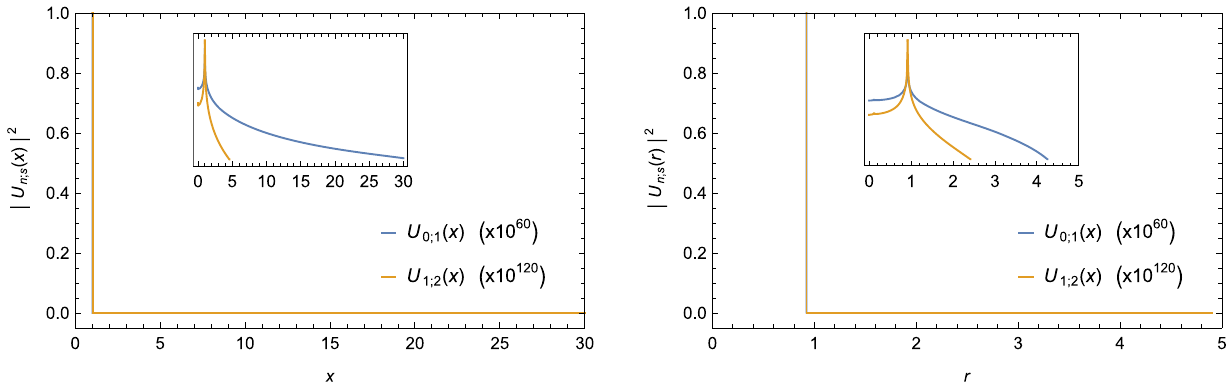
Fig. 6 (dS) Case 2: a > 0. The first two squared QBS radial wave eigenfunctions as a function of the new radial coordinate x (left) and radial coordinate r (right); a = 0 . 20, (cid:2) = 0 . 1, M = 1 / 2. The units are in multiples of C n ; s